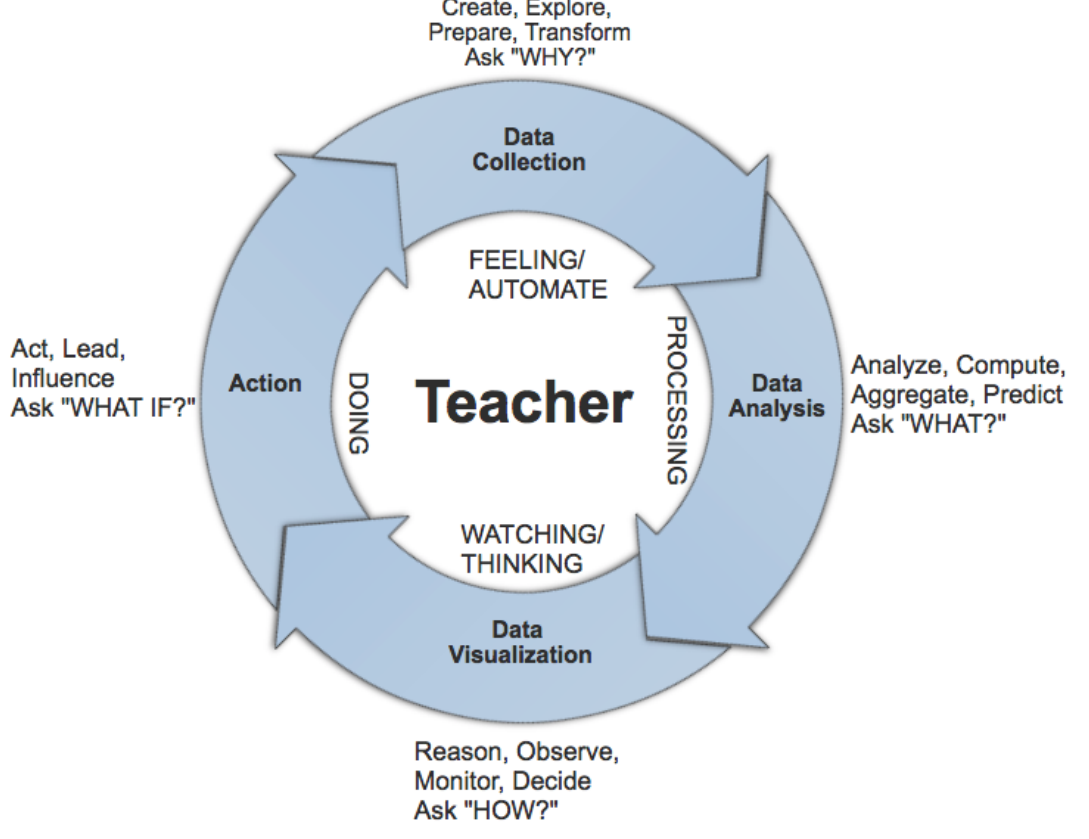
Figure 1. TOM teaching analytics